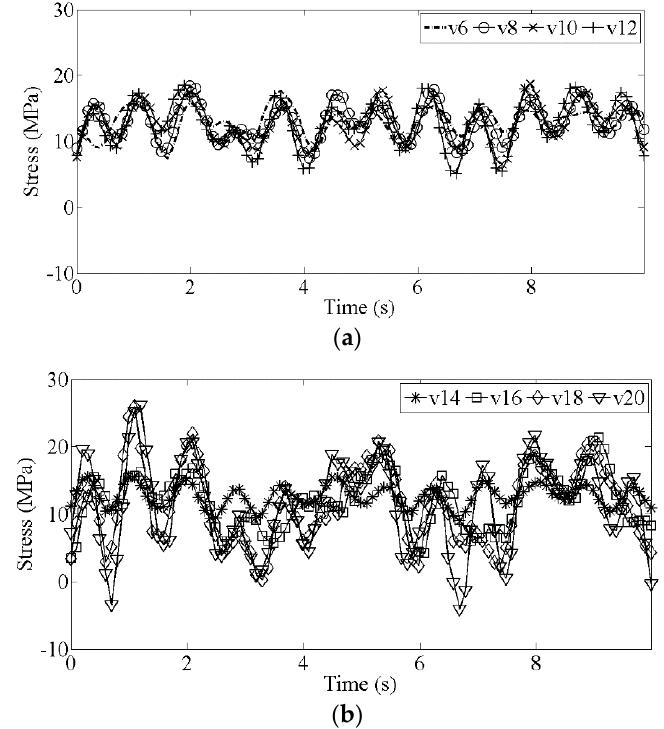
Figure 12. Time histories of σ x,vA at different mean wind speeds: ( a ) Mean wind speed of 6 – 12 m/s; ( b ) Mean wind speed of 14 – 20 m/s.